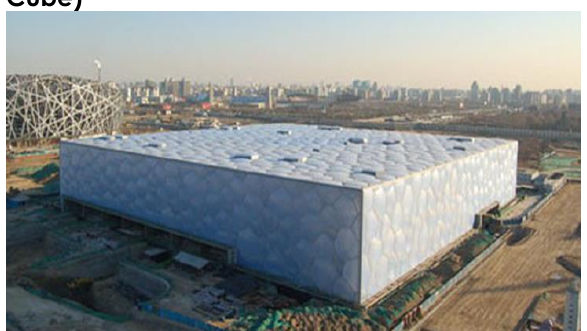
Figure 5. Water Cube [Url